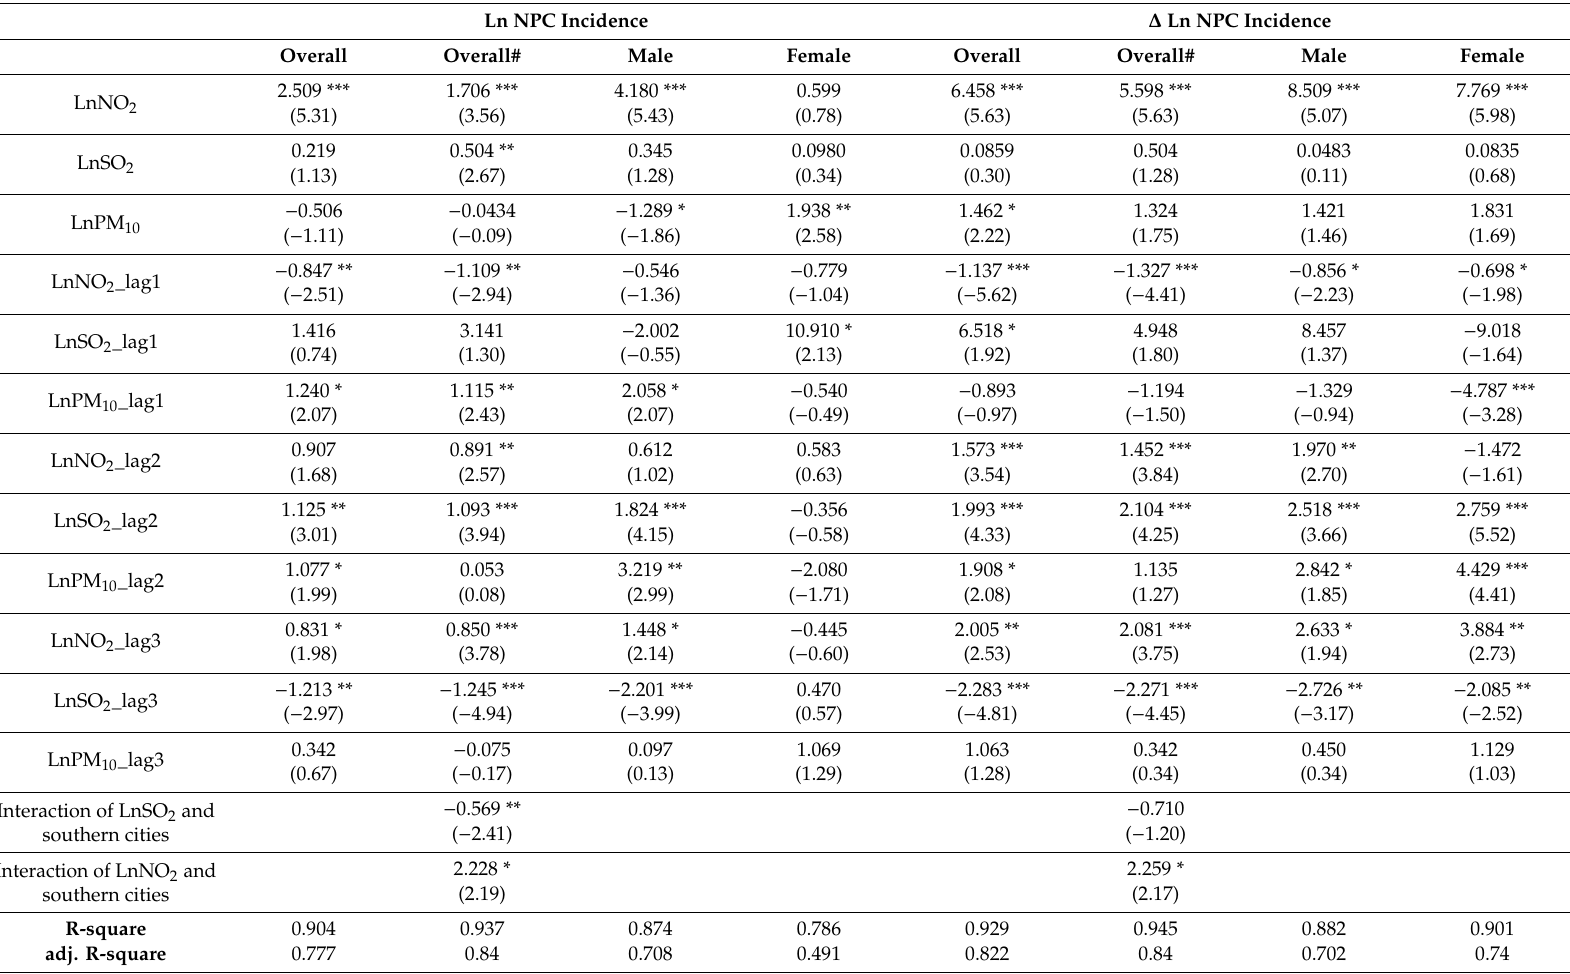
Table 2. Association of air pollution with NPC incidence and its growth